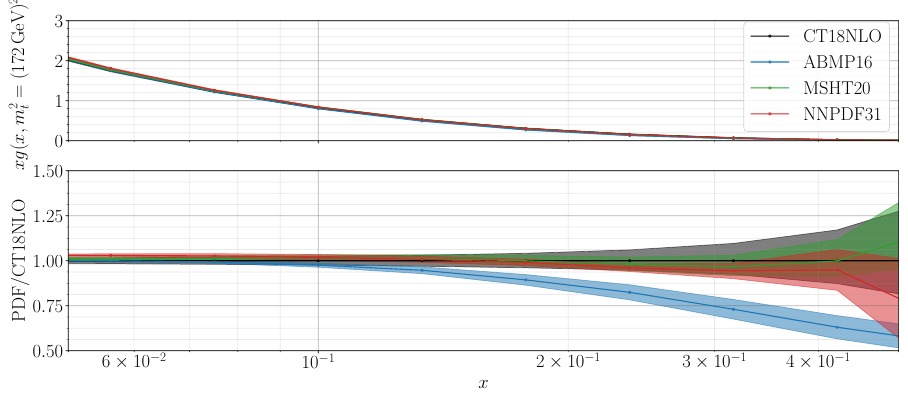
Figure 22 . Gluon PDFs obtained with the NLO PDF sets ABMP16, CT18NLO, MSHT20 and NNPDF3.1 as a function of the momentum fraction x for Q 2 = m 2